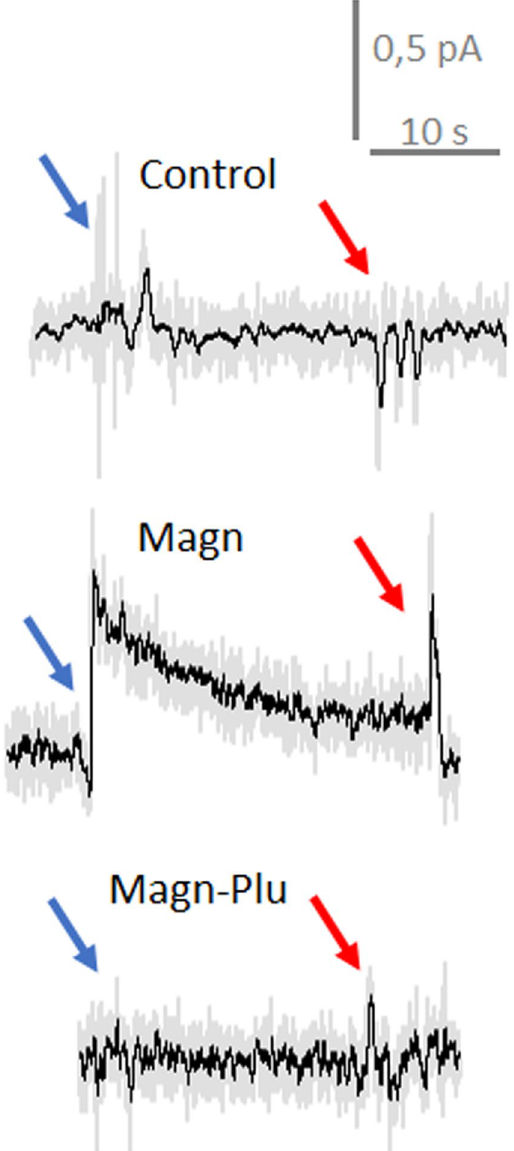
Figure 6. ROS intracellular measurements in individual LNCaP cells. Voltammograms before and after penetration of cells with the nanoelectrode. Voltage is applied vs Ag/AgCl. Representative current traces of a nanoelectrode polarized at + 800 vs Ag/AgCl inside and outside LNCaP cells. Red and blue arrows indicated, respectively, the moment of penetration and retraction. Similar traces were obtained from 5 different cells from each sample by the same electrode. Control – ROS intracellular measurements in pure cells after 3 h in HBSS; Magn - ROS intracellular measurements in cells incubated with Magn NP during 3 h, Magn-Plu - ROS intracellular measurements in cells incubated with Magn-Plu NP during 3 h. Grey curves are pure records, black curves are records with 100